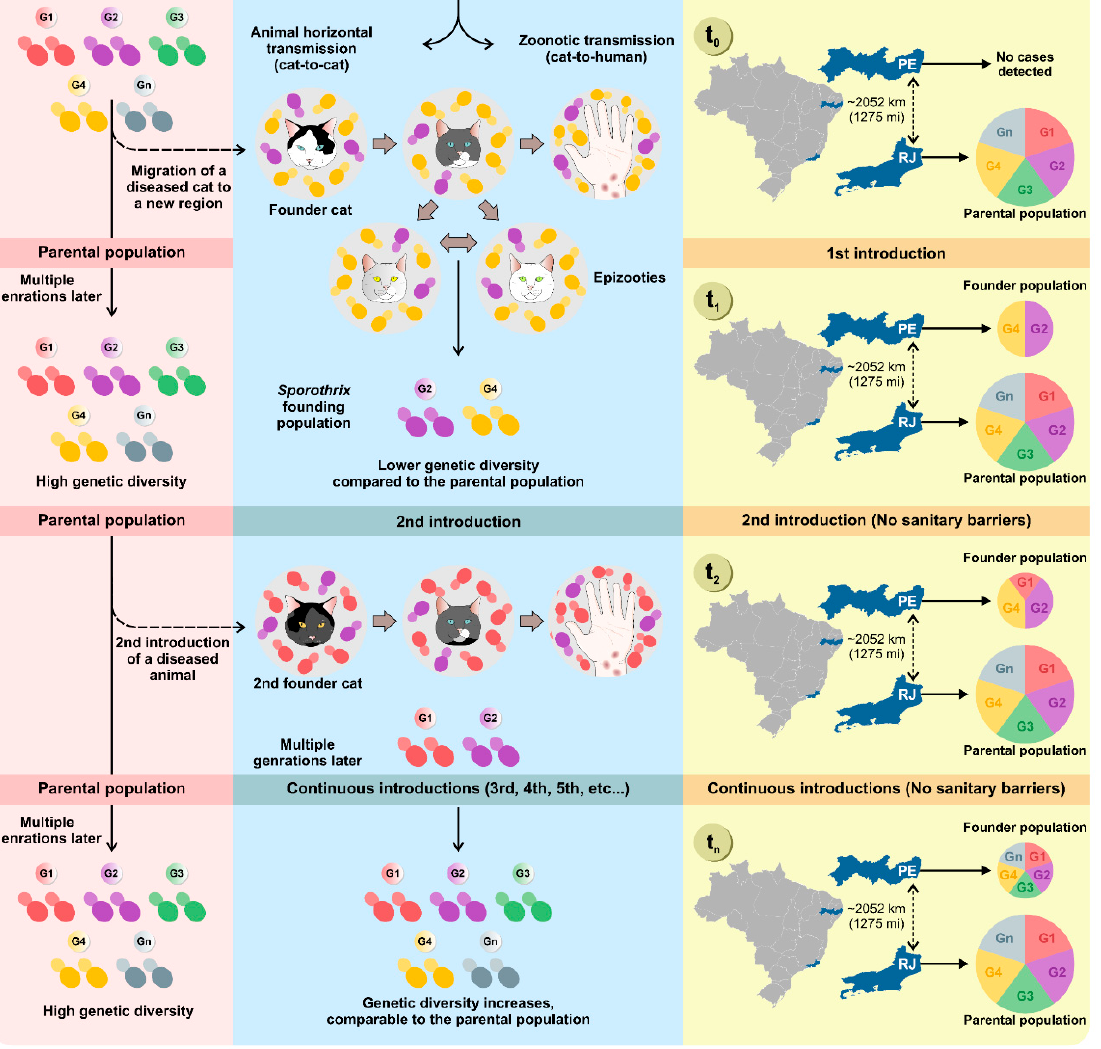
Figure 3. Founder effect events explain the expansion dynamics of cat-transmitted sporotrichosis. The molecular studies developed by de Carvalho et al. [101] offer new bases for proposing public policies to mitigate sporotrichosis. The S. brasiliensis genotypes (e.g., G1, G2, G3, G4, G5, Gn) infect cats living in the metropolitan region of Rio de Janeiro and are considered the parental population. Eventually, a sick cat infected with a single or a group of genotypes (e.g., G2 and G4) is taken to a new area (e.g., Pernambuco), where it will establish a founder population, transmitting S. brasiliensis to other cats (epizootics) or humans (zoonoses). A study of genetic diversity at time one (t1) will reveal that the founder population has less genetic diversity when compared to the parental population. However, the absence of sanitary barriers and the continuous exchange of diseased animals taken by their tutors from the parental-to-founder population will gradually (t2, t3, t4, tn) reconstitute the genetic diversity in the founding population and accelerate the pace of diversification.